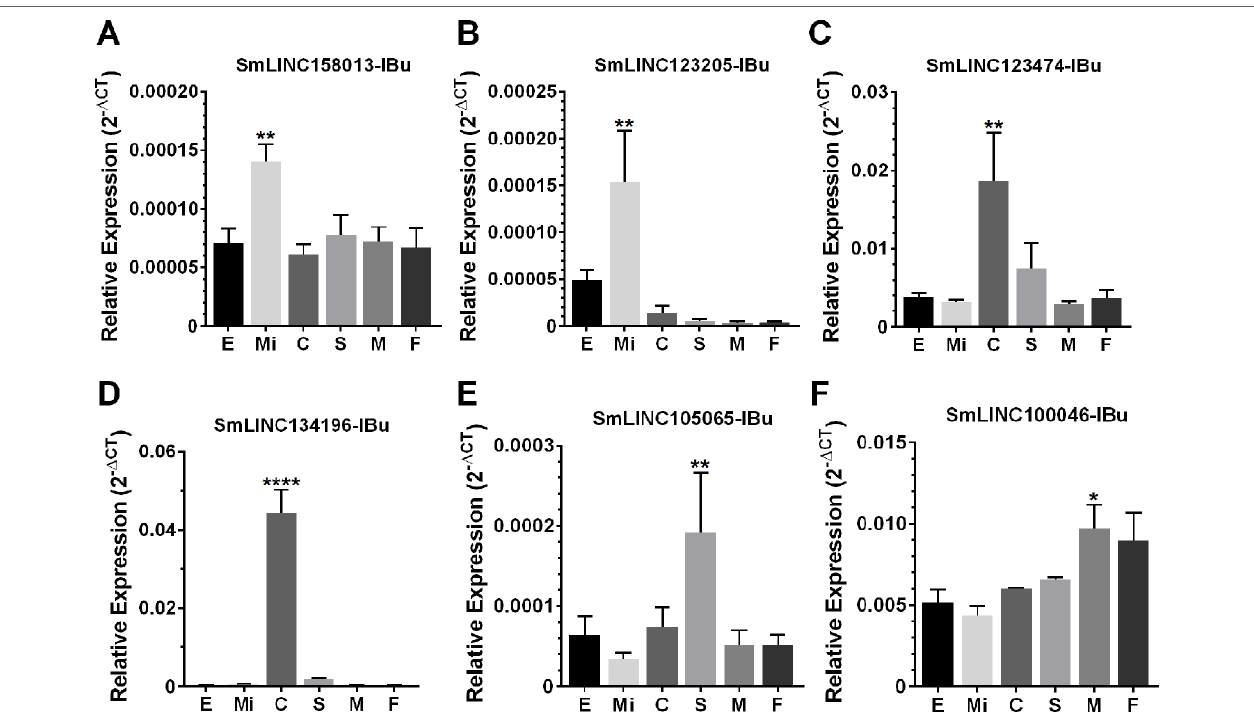
FIGURE 10 | Confirmation by RT-qPCR of the module-specific lincRNAs relative expression. Six lincRNAs were measured at different developmental stages of S. mansoni . From left to right in the x-axis, lincRNAs were measured in RNA samples from eggs (E), miracidia (Mi), cercariae (C), in vitro mechanically transformed schistosomula cultivated for 24 h (S), adult males (M) and females (F). The lincRNAs relative gene expression was calculated against the geometric mean of two housekeeping genes: Smp_090920 and Smp_062630. (A) and (B) show SmLINC158013-IBu and SmLINC123205-IBu representing the purple module, specific for miracidia/sporocysts. In (C) and (D), the SmLINC123474-IBu and SmLINC134196-IBu representing the cercariae-specific tan module. In (E), the schistosomula-specific lincRNA SmLINC105065- IBu from the magenta module and (F) the adult male-specific lincRNA SmLINC100046-IBu from the turquoise module. Bars represent standard deviation of the mean from four biological replicates for each stage. Two technical replicates were assayed for each of the four biological replicates per stage. The ANOVA Tukey test was used to calculate the statistical significance of the expression differences among the parasite stage samples (*p value ≤ 0.05; **p value ≤ 0.01; ****p value ≤ 0.0001). For clarity purposes, we show only the highest p value obtained in the ANOVA Tukey test for expression comparisons against one another among the